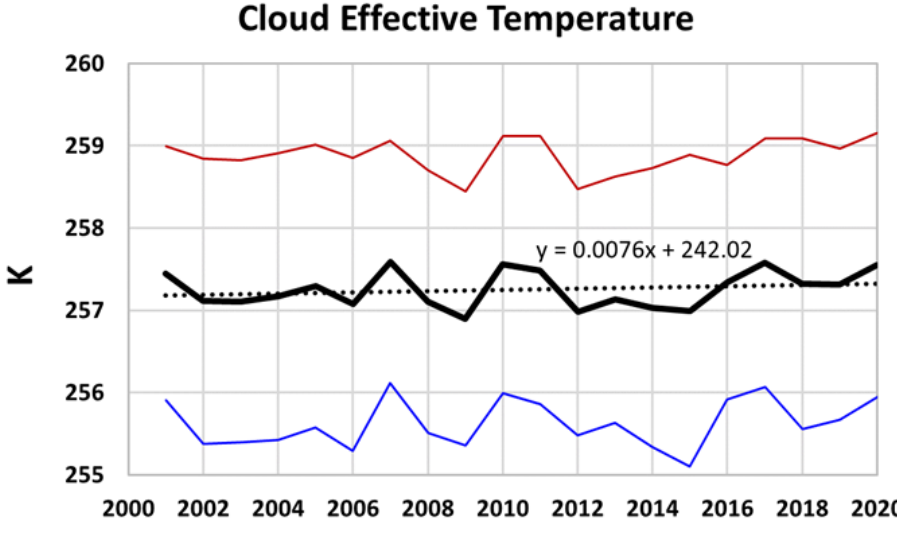
Figure 6. Outgoing longwave flux (TOA ) over “Clear Sky” ( a ) and “Cloudy Areas” ( b ). The slope over the “Cloudy Areas” is eight times higher.